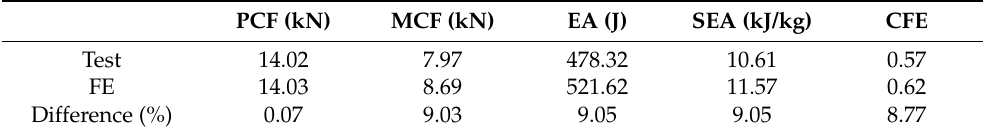
Figure 7. Comparison between the experiment and FE simulation: ( a ) deformation process and ( b ) force-displacement curve. Table 1. Comparison of various energy absorption criteria between the test and FE simulation.